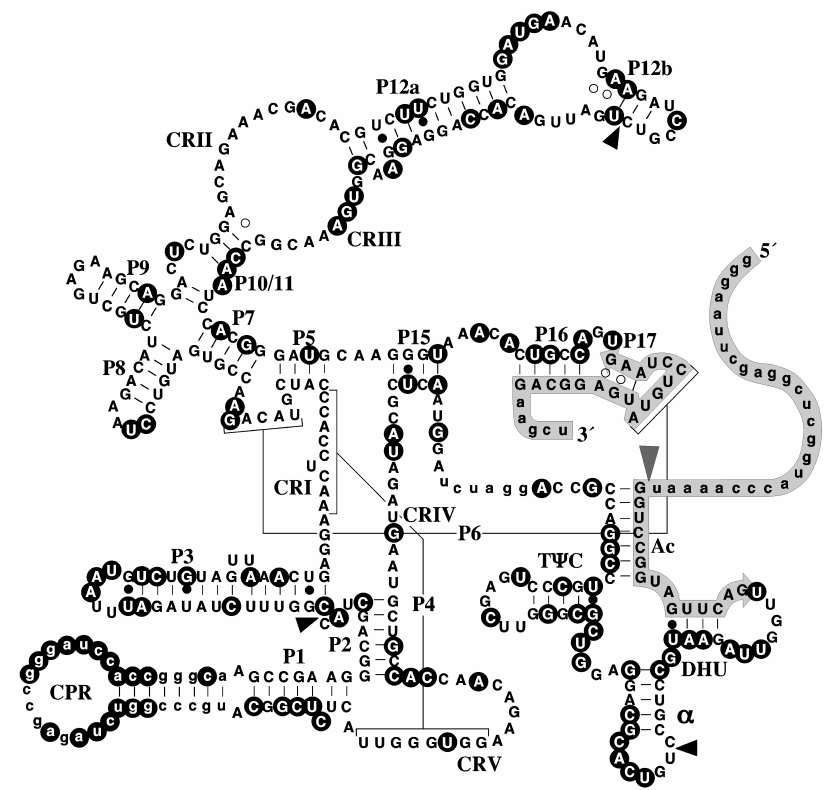
Figure 1. Secondary structure of the circularly permuted Methanobacterium formicicum RNase P RNA: Bacillus subtilis pre-tRNA Asp RNA. Sequences at the 5 ′ and 3 ′ ends of the RNA en- closed by a gray box are the locations of the oligonucleotide primers used in each round of selection. Lowercase nu- cleotides represent non-native se- quences: the sequence joining the tRNA and RNase P RNA; the sequence joining the native 5 ′ and 3 ′ ends of the RNase P RNA (CPR, distal to P1); and the 5 ′ leader sequence. Helices in the RNase P RNA are designated P1 to P17 according to Haas et al. (1996). Conserved regions in the RNase P RNA are designated CRI to CRV ac- cording to Chen and Pace (1997). Transfer RNA helices are labeled Ac (acceptor stem), DHU (dihydrouracil stem), α (anticodon stem) and T Ψ C (T-pseudouracil-C stem). The RNase P cleavage site is indicated by the gray arrow. Nucleotides highlighted in black are in positions at which mutations (transition, transversion, or deletion) were observed among the 50 se- quenced active RNAs. Sites of inser- tions among these sequences are indicated by the black